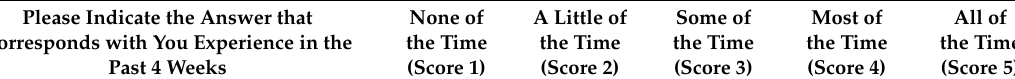
Table A1. Questions from the Kessler psychological distress scale (K10).